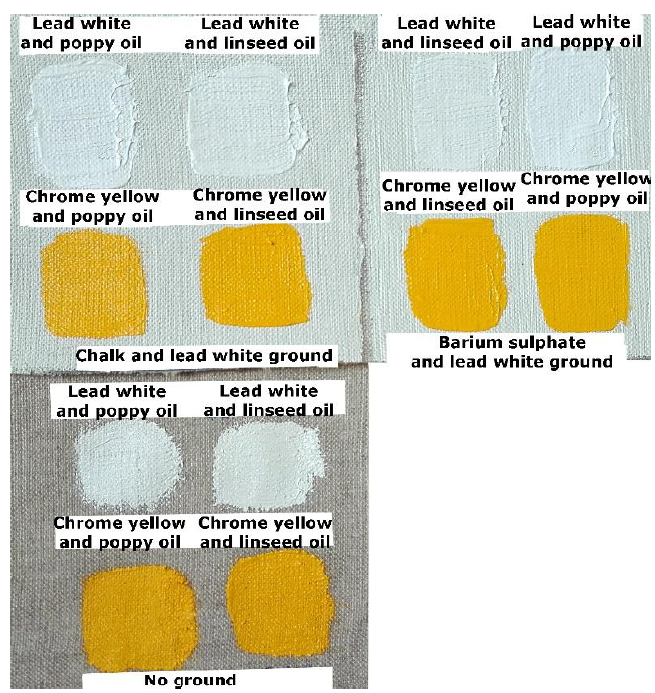
Figure 1. Normal light image of the experimental samples examined.